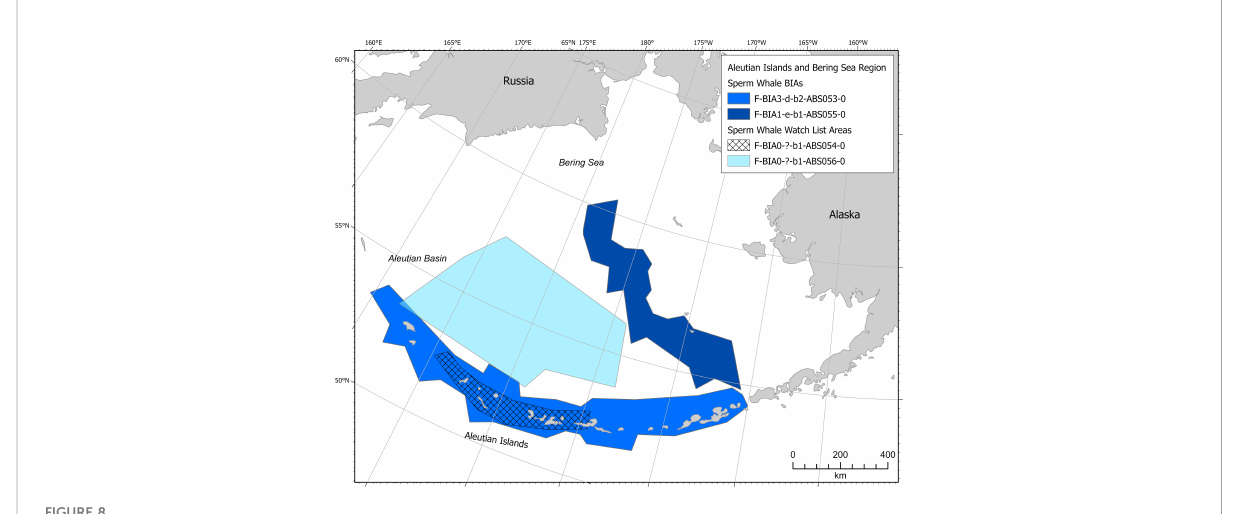
FIGURE 8 Aleutian Islands and Bering Sea region sperm whale BIAs and watch list areas.